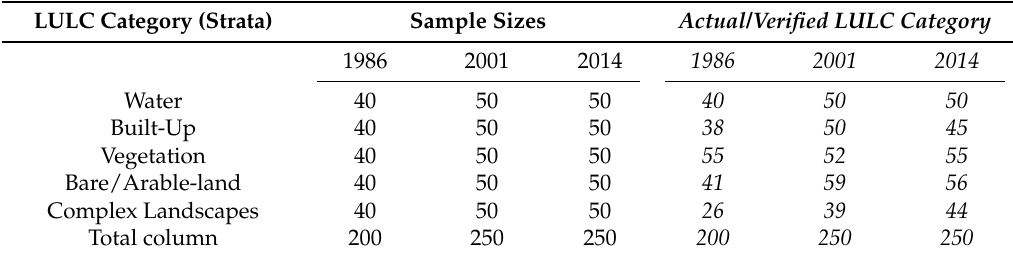
Table 4. Sample sizes allotted to the targeted LULC classes in 1986, 2001 and 2014. LULC Category